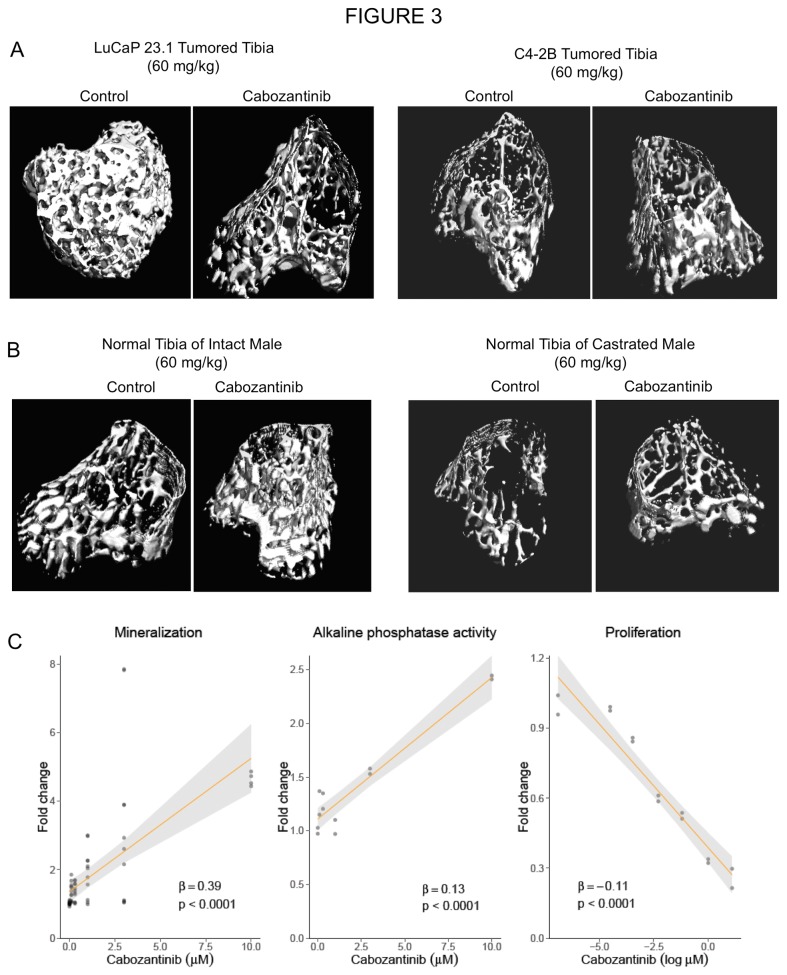
Cabozantinib attenuates bone responses to tumor and increases normal bone volume in tumor unaffected areas.A. LuCaP 23.1 and C4-2B cell growth in tibiae causes large increases in trabecular bone volume. µCT images show that cabozantinib alleviates the bone response to both tumors. In LuCaP 23.1 tumored tibiae cabozantinib caused decreases in BV, while increases in BV were detected in C4-2B tumored tibiae of cabozantinib-treated animals vs control-tumored tibiae. The overall effects are combination of abolishment of tumor effects on the bone as well as cabozantinib effects on normal bone. Details of the effects are provided in Table 1. B. Analysis of non-tumored contralateral tibiae of the experimental animals shows that treatment with cabozantinib results in increased bone volume in both intact and castrated male mice. C. In
vitro, cabozantinib treatment inhibits proliferation of MC3T3 pre-osteoblast cells in a concentration-dependent manner, while promoting ALP activity and mineralization. Fold change in cells response measures was estimated from a single experiment that was repeated three times, and association with cabozantinib concentration was quantified and tested using linear regression models.